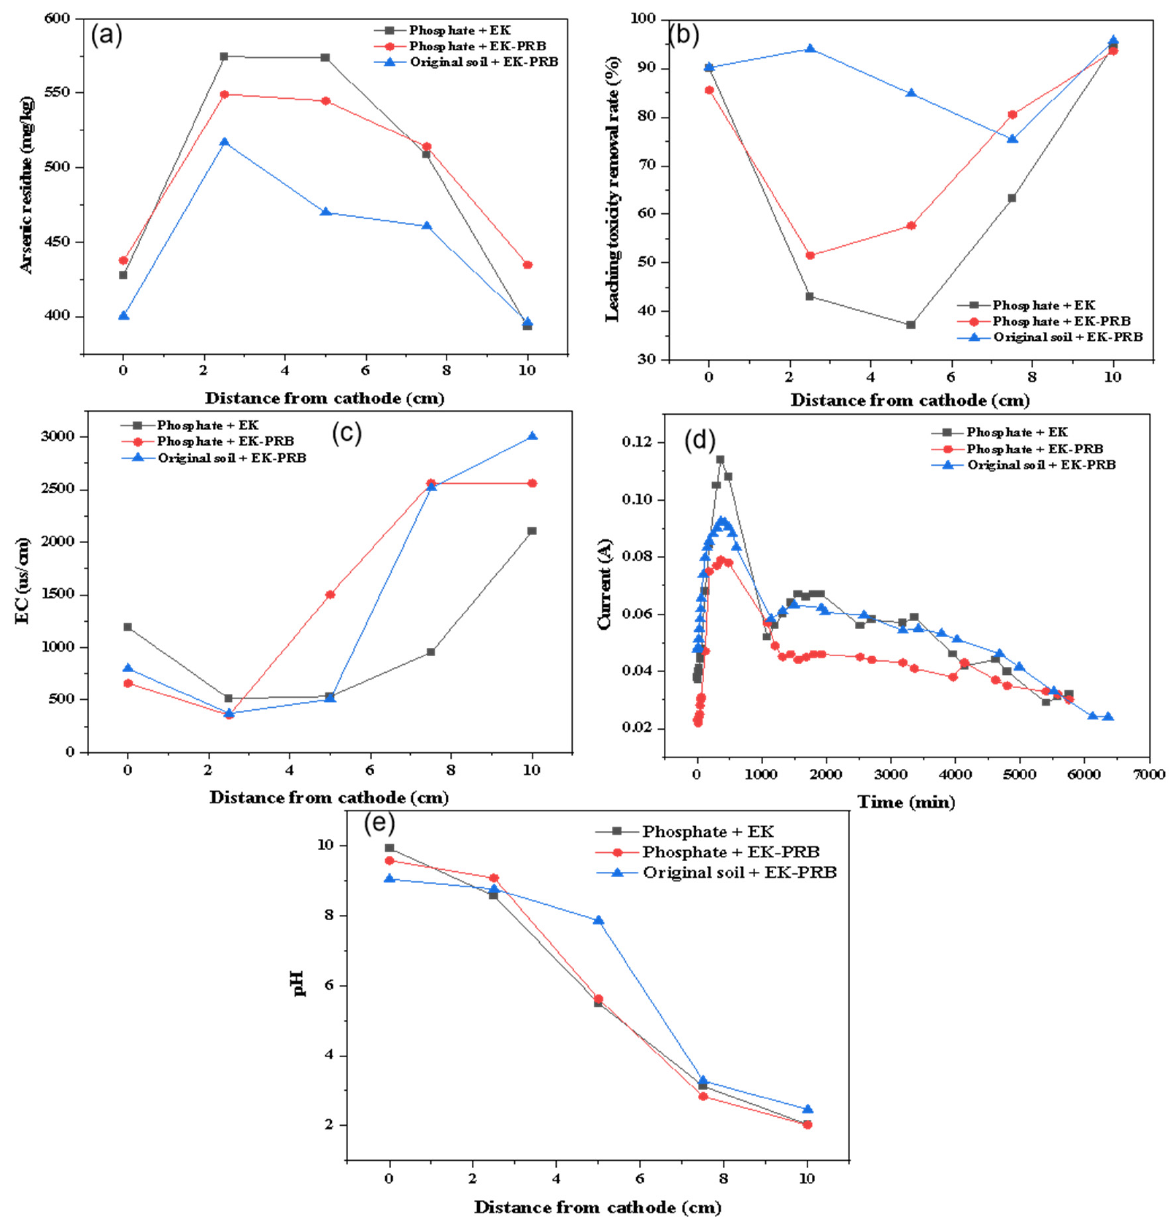
Figure 4. Effect of phosphate for the remediation of arsenic contaminated soil by EK-PRB. Arsenic residue ( a ), leaching toxicity removal rate ( b ), EC ( c ), current ( d ) and pH ( e ).